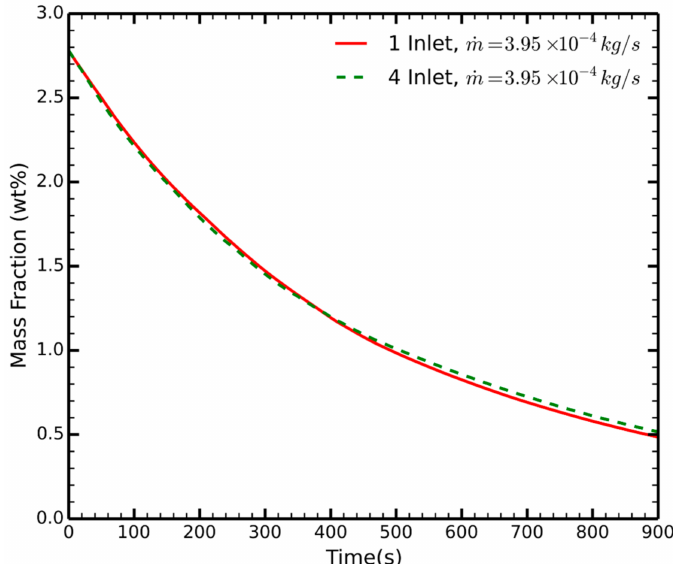
Figure 9. Time evolution of the mass fraction of water in the ullage for the single-inlet and four-inlet cases. The inlet velocity of the two cases is adjusted accordingly so that the mass flow rate remains the